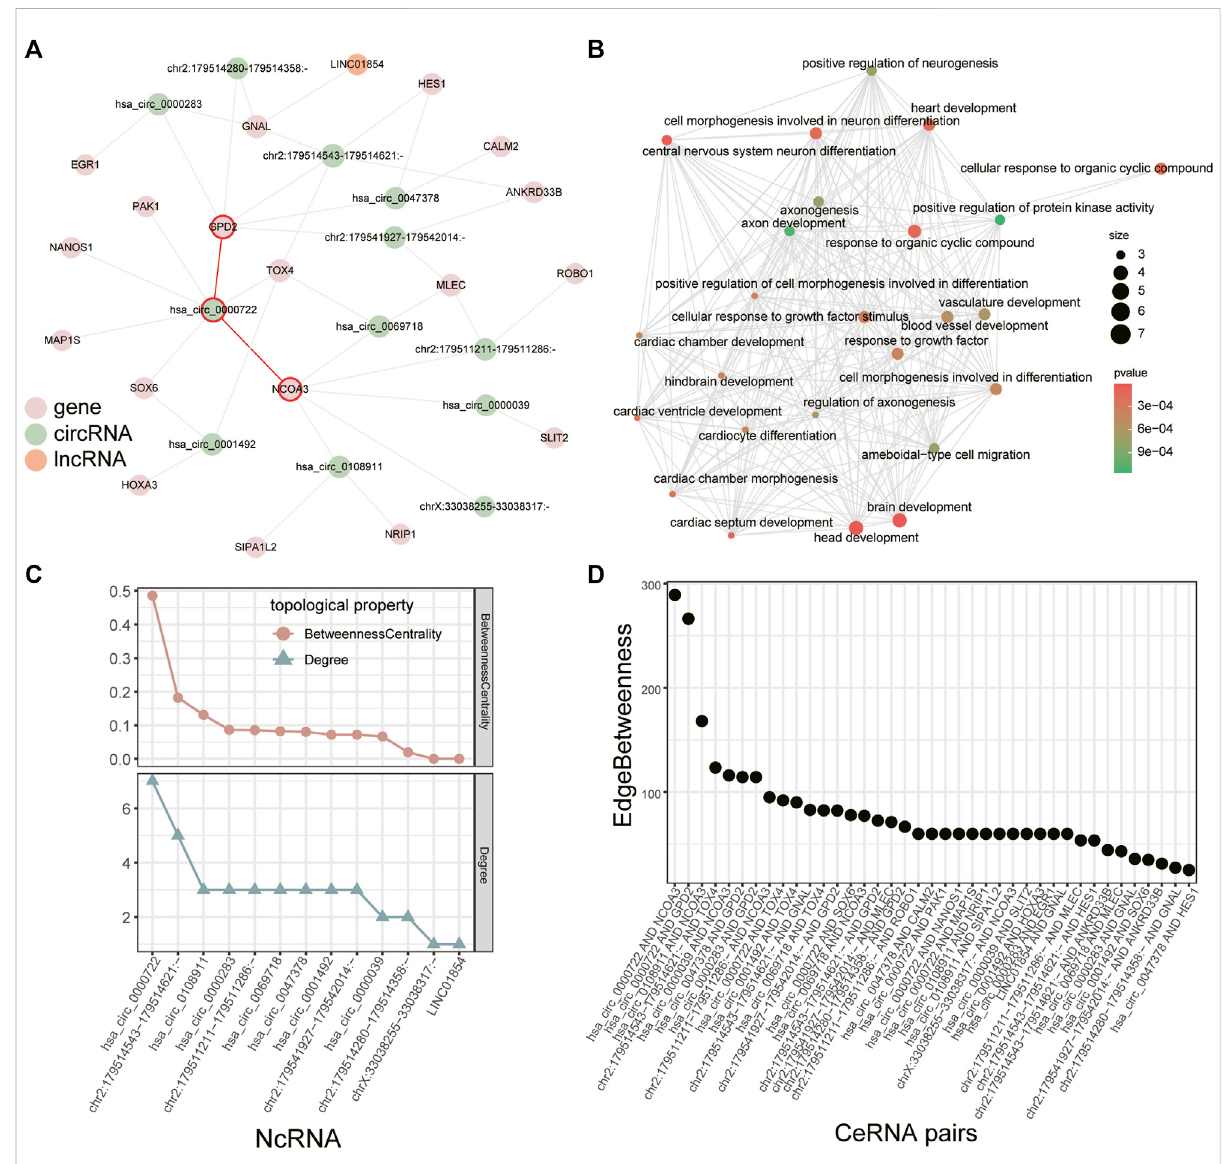
FIGURE 5 Module in the combined ceRNA network. (A) The largest module in the combined ceRNA network. The circRNA-mRNA pairs of hsa_circ_0000722 are highlighted in red. (B) GO enrichment analysis for the mRNAs in the module. (C) Distribution of degree and betweenness centrality of ncRNAs in the module. (D) Edge betweenness centrality of lncRNA/circRNA-mRNA pairs in the